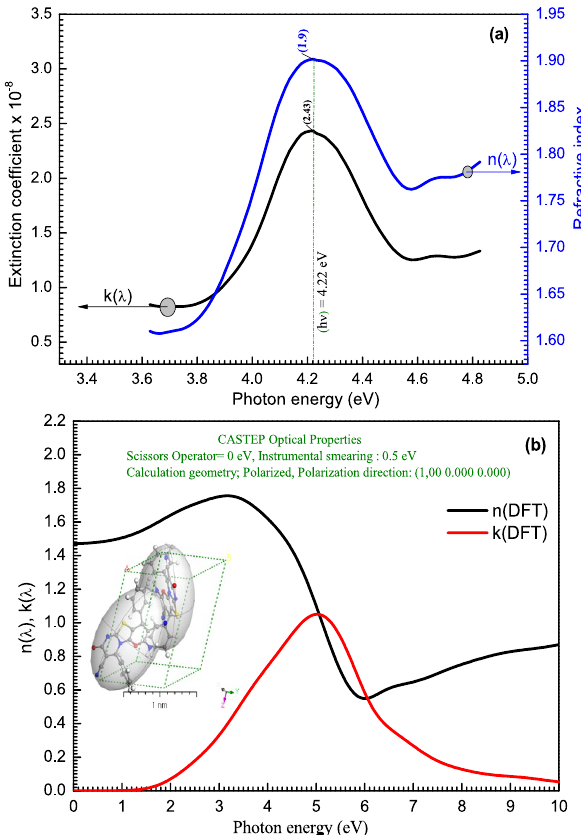
Figure 9. The extinction coefficient and refractive index of ( a ) [ThiPy-3,8-Dc] TF and ( b ) simulated computations of the isolated molecule using CASTEP/DFT. The inset is a 3D triclinic lattice-type done using the polymorph computation